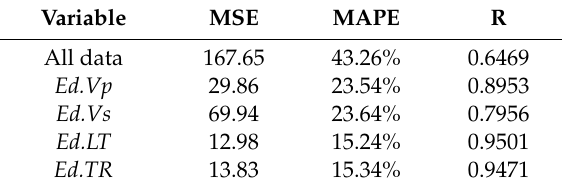
Figure 13. Analysis of general regression for individual Ed and fc . Table 9. Comparison of MSE, MAPE, and R values for predicted fc and measured fc .